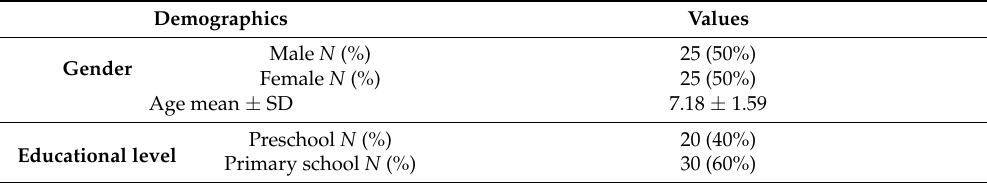
Table 1. Demographics and mean values of Dysfunctional Voiding Symptom